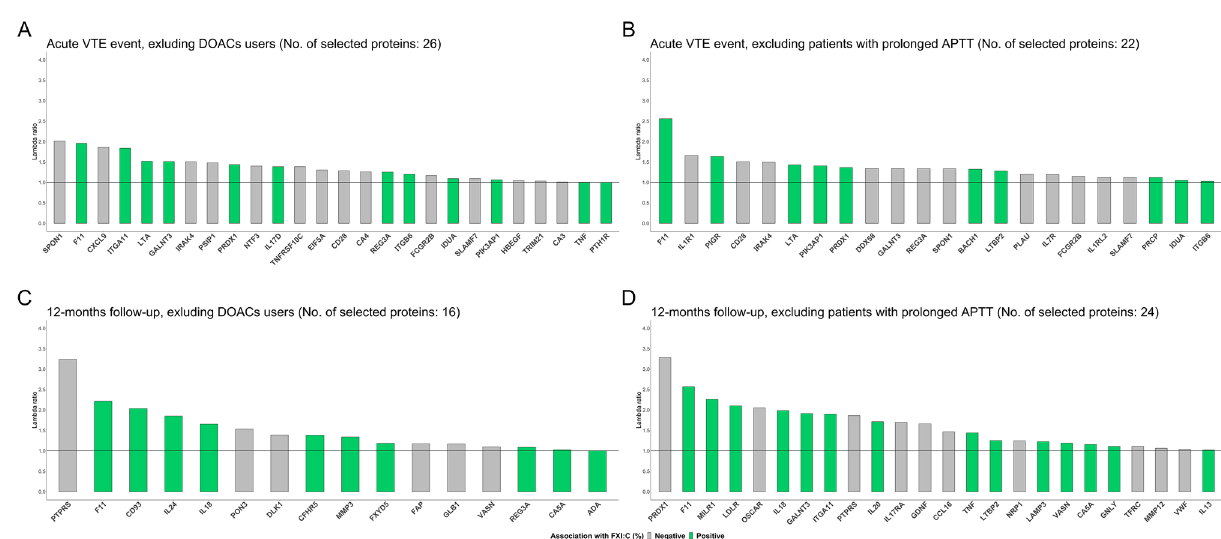
Figure 3. Sensitivity analyses excluding DOAC users, and individuals with normal and high FXI:C (%) and prolonged APTT. This figure shows the proteins selected by LASSO-regularized regression models. Panels A and C depict the size effect and association with FXI:C of the proteins when DOAC users are excluded in the acute VTE event and 12 month follow-up models. Panels B and D depict the selected proteins when individuals with normal and high FXI:C (%) and a prolonged APTT are excluded for each